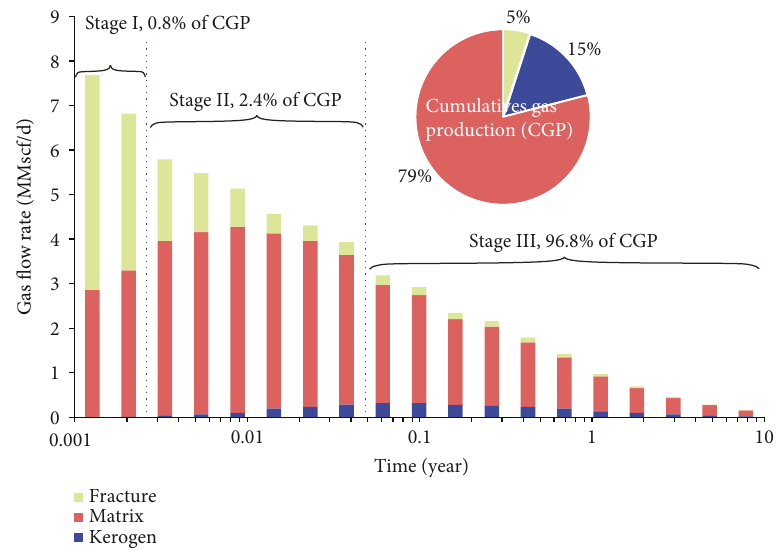
Figure 5: Cumulative production curves in di ff erent